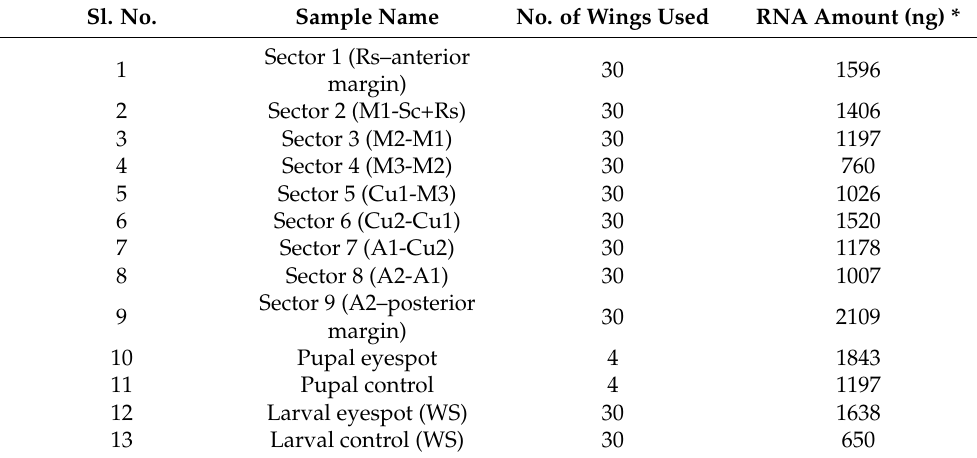
Figure 4. Venation nomenclature of Bicyclus anynana larval hindwing used for dissection and isolation of sector-specific transcriptomes using LCM. Table 3. RNA concentration obtained after pooling microsamples from different wings. The sector description is provided in Figure 4.